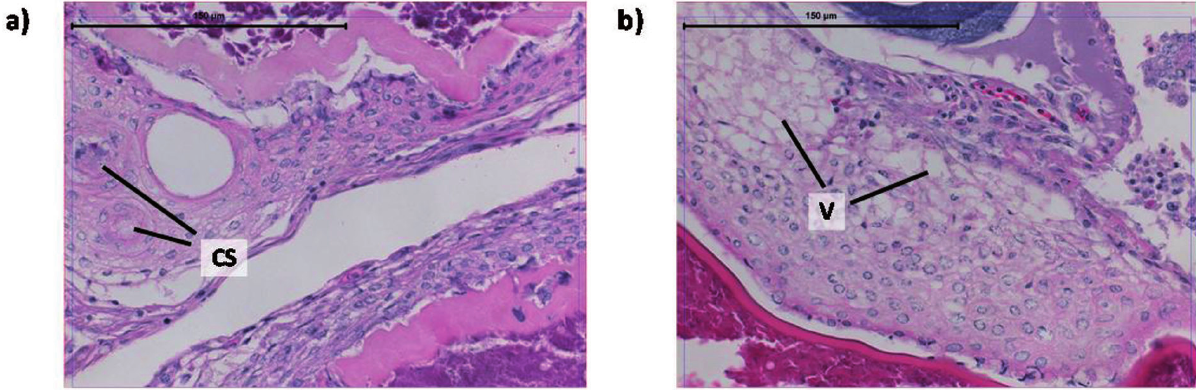
Fig. 3 . – Microphotography of a) circular structures (CS) formed of concentric layers of squamous cells and b) vacuoles (V). Scale bar=150